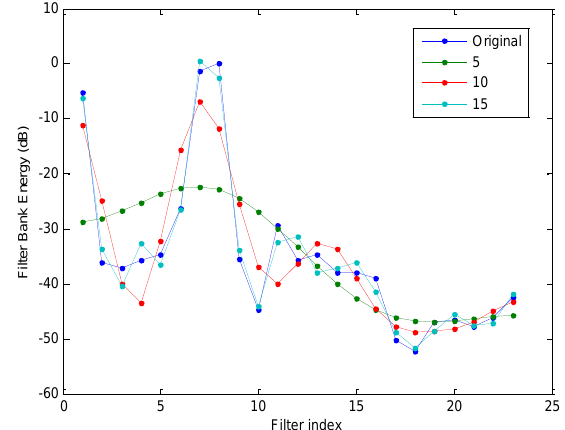
Figure 14. Original and approximate value of the FBE for different numbers of cepstral coefficients.